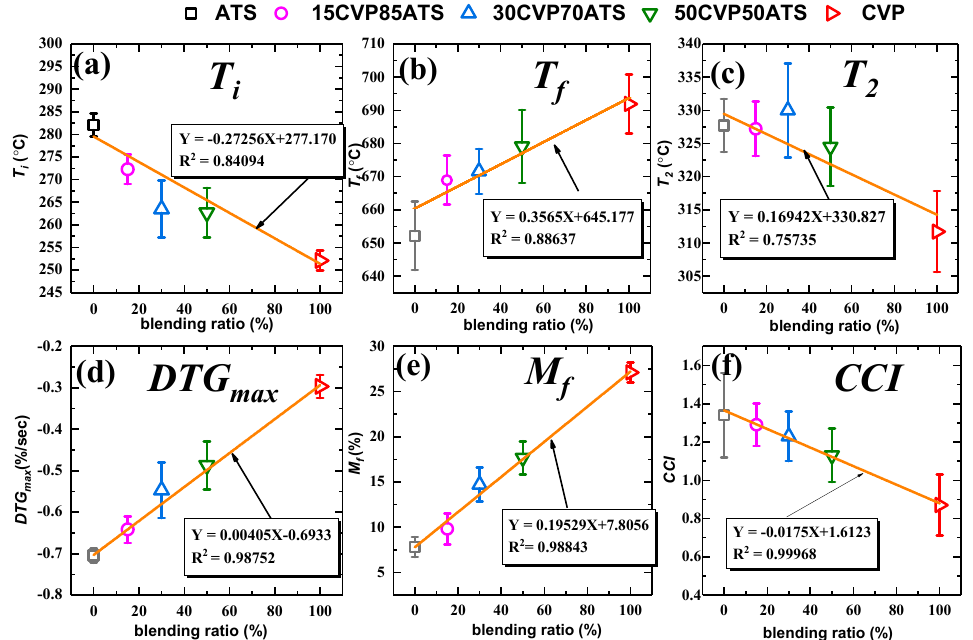
Figure 9. ( a ) The relationship between T i and CSBs; ( b ) the relationship between T f and CSBs; ( c ) the relationship between T 2 and CSBs; ( d ) the relationship between DTG max and CSBs; ( e ) the relationship between M f and CSB; and ( f ) the relationship between CCI and CSBs.